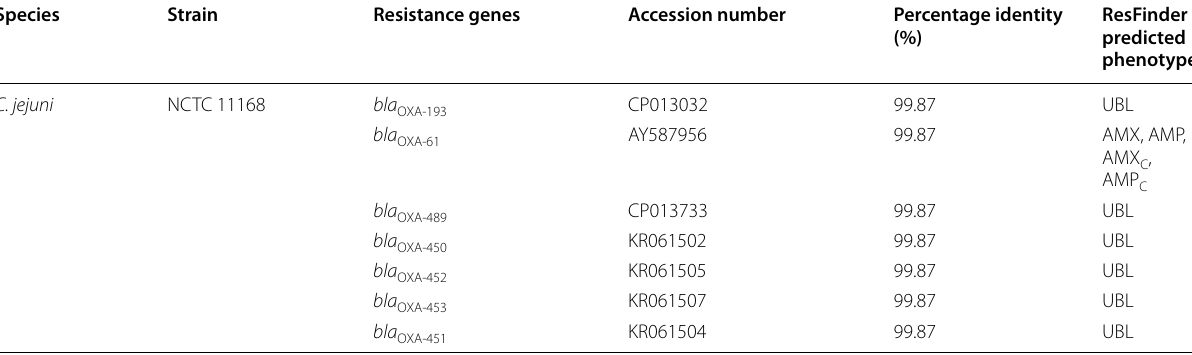
Table 4 ResFinder results for resistance genes of Campylobacter jejuni